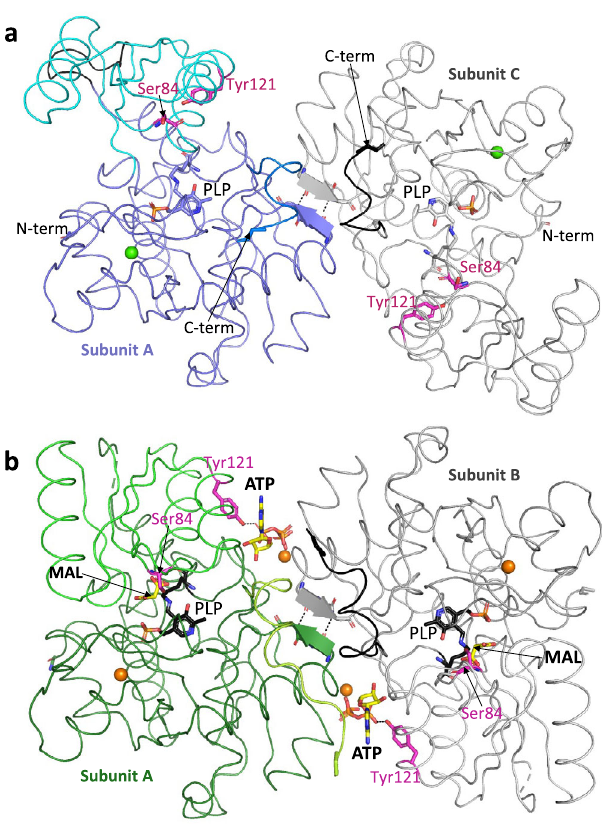
Fig. 2 Crystal structures of ‘ open ’ and ‘ closed ’ human SR dimers. a View of 1.8 Å ‘ open ’ holo SR structure (pdb code: 6ZUJ) with Ca 2 + ions (green spheres). The AC dimer is shown as a C α ribbon with the A subunit in purple/cyan and the C subunit in grey. Also shown are Ser 84 and the side- chain of Tyr 121 (sticks, magenta carbons) and the PLP moiety covalently linked to Lys 56 (sticks, blue carbons). The hydroxyl of Tyr 121 is within H-bonding distance of the main-chain carbonyl oxygen of Ser 84 (dotted line) in subunit A. Residues 279 – 281 at the dimer interface form a short β - strand with two intersubunit H-bonds (dotted lines). b View down twofold axis of 1.60 Å human SR dimer (pdb code: 6ZSP) with ATP and malonate (sticks, yellow carbons) and Mg 2 + ions (orange spheres). The A/B dimer is shown as a C α ribbon with the A subunit in green/dark green and the B subunit in grey. Also shown are Ser 84 and the side-chain of Tyr121 (sticks, magenta carbons) and the PLP moiety covalently linked to Lys 56 (sticks, black carbons). The side-chain hydroxyl of Tyr121 donates an H-bond to ATP (dotted line) in both A and B